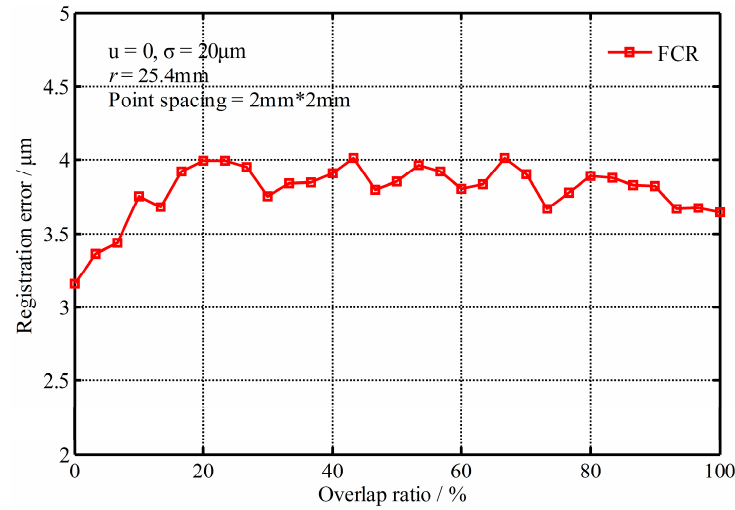
Figure 9. Registration errors changed with the overlapping ratio.